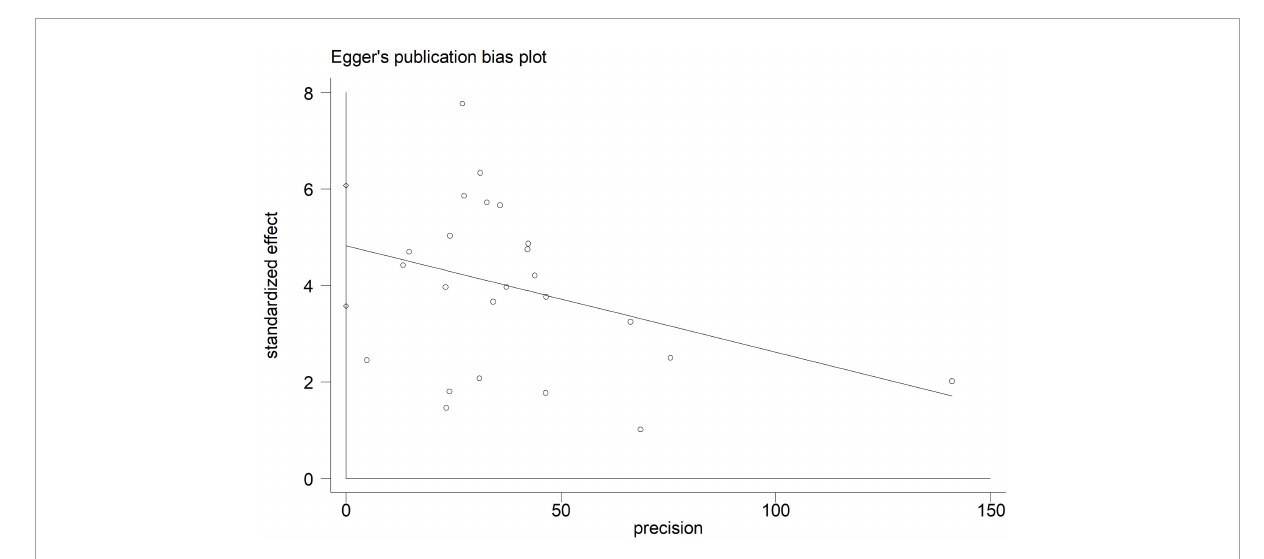
FIGURE7 Egger’s funnel plot analysis of cardiopulmonary bypass (CPB) in